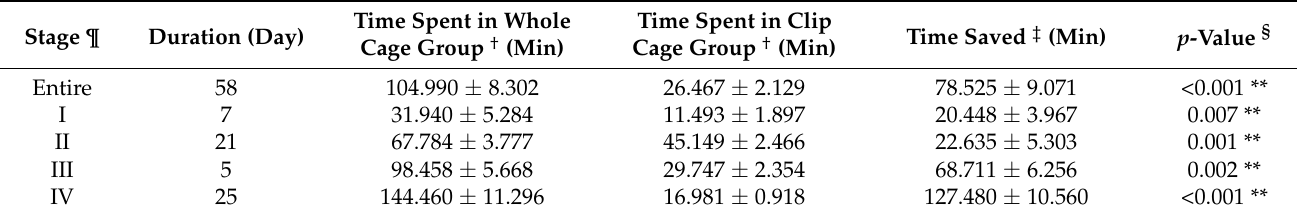
Table 3. Time spent in different stages of the Sitobion avenae life table